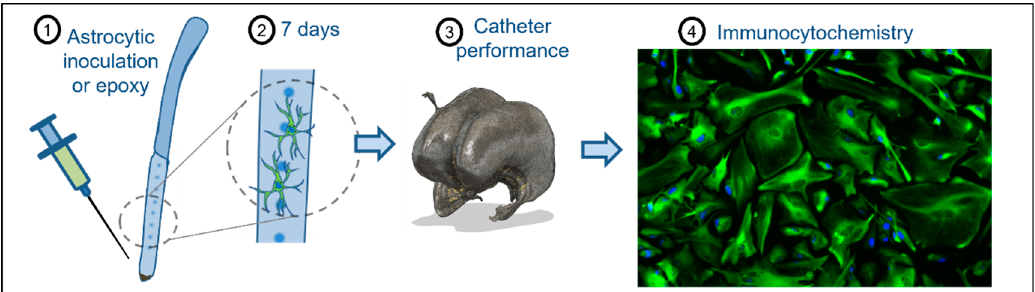
Figure 1. Schematic representation of the catheter occlusion procedure and testing. (1) Astrocytes were inoculated into the ventricular catheter using Vitrogel as an extracellular matrix for 7 days (2). Catheter performance was tested using the 3D brain phantom (3). Anti-GFAP (green) and DAPI (blue) immunohistochemistry staining was performed to quantify cellular attachment